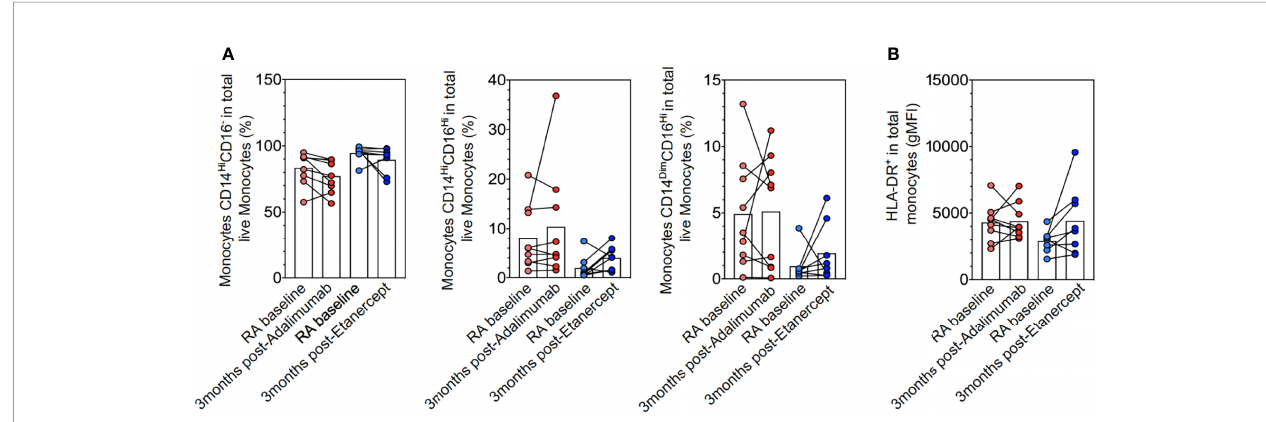
FIGURE 3 | Monocyte subpopulations and activation. Ex vivo CD14 and/or CD16 monocytes (A) and HLA-DR (B) expression in rheumatoid arthritis (RA) at baseline (n = 17), RA at 3 months after adalimumab (ADA) (n = 9), and RA at 3 months after ETA (n = 8) determined by fl ow cytometry analyses of frozen peripheral blood mononuclear cells (PBMCs with anti-HLA-DR, anti-CD14, anti-CD16, anti-CD2, anti-CD19, and anti-CD56 antibodies. Results are shown as symbols, lines, and mean ± SEM and were compared by Kruskal – Wallis test with Dunn ’ s multiple comparisons and the two-tailed nonparametric test.